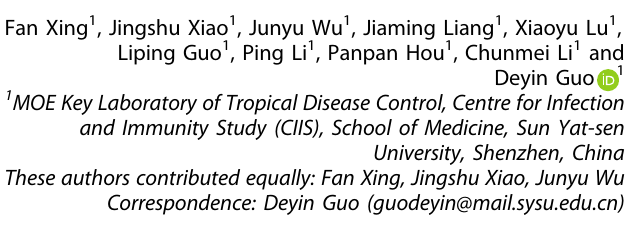
Fig. 1 a Knockdown of PTEN led to resistance to anti-PD-1 therapy. C57 mice were implanted with 3*10 5 GL261-shNC or GL261-shPTEN cells on day 0. Then, the mice were treated with anti-PD-1 antibody (10 mg/kg) at day 8th, 10th, and 12th. The survival times of mouse was monitored. b Knockdown of PTEN increased the sensitivity to OV. Nude mice were implanted with 3 × 10 6 GSC1-shNC or GSC1-shPTEN cells on day 0. Then, the mice were treated with 3 × 10 7 PFU VSV on day 5 through 7. c The timeline of drugs delivery. d Left panel: tumor growth was monitored via bioluminescence imaging of luciferase activity in GL261-shPTEN xenograft mice ( n = 6 per group) on day 8th, 13th, and 17th. Right panel: quantitative radiance of mice on day 17 was analyzed. e Kaplan – Meier survival curve of mice bearing GL261-shPTEN1 tumors. f Percentages of CD4 + T cells, CD8 + T cells among CD45 + cells and Tregs (Foxp3 + ) among CD4 + T cells were analyzed in brain tumor tissue. g The function of CD8 + T cells was evaluated by measuring IFN γ and granzyme B. h The survived mice ( n = 5) from the triple